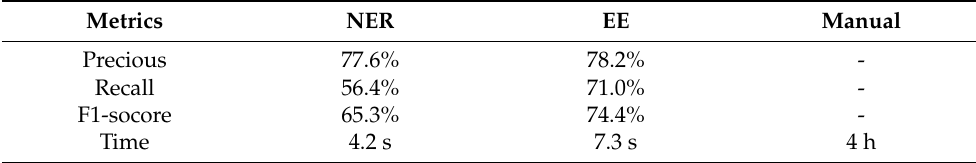
Table 12. FP recognition and classification results.